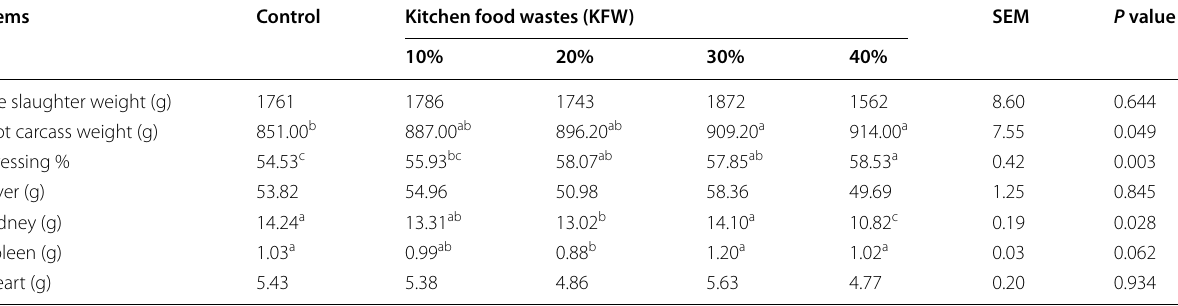
a,b,c Means with different superscripts in the same row differ significantly ( P < 0.05)